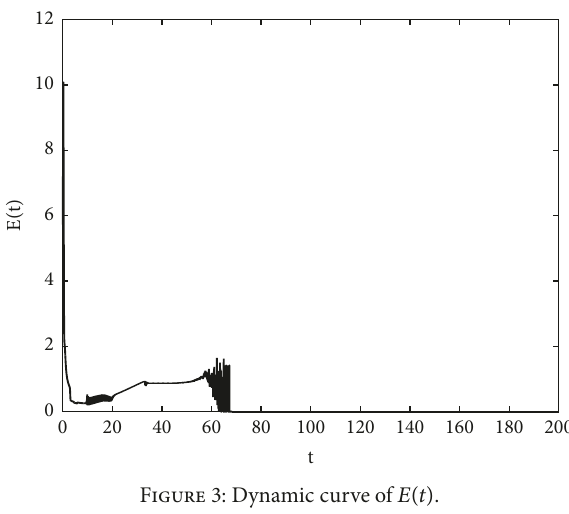
Figure 3: Dynamic curve of 𝐸(𝑡)